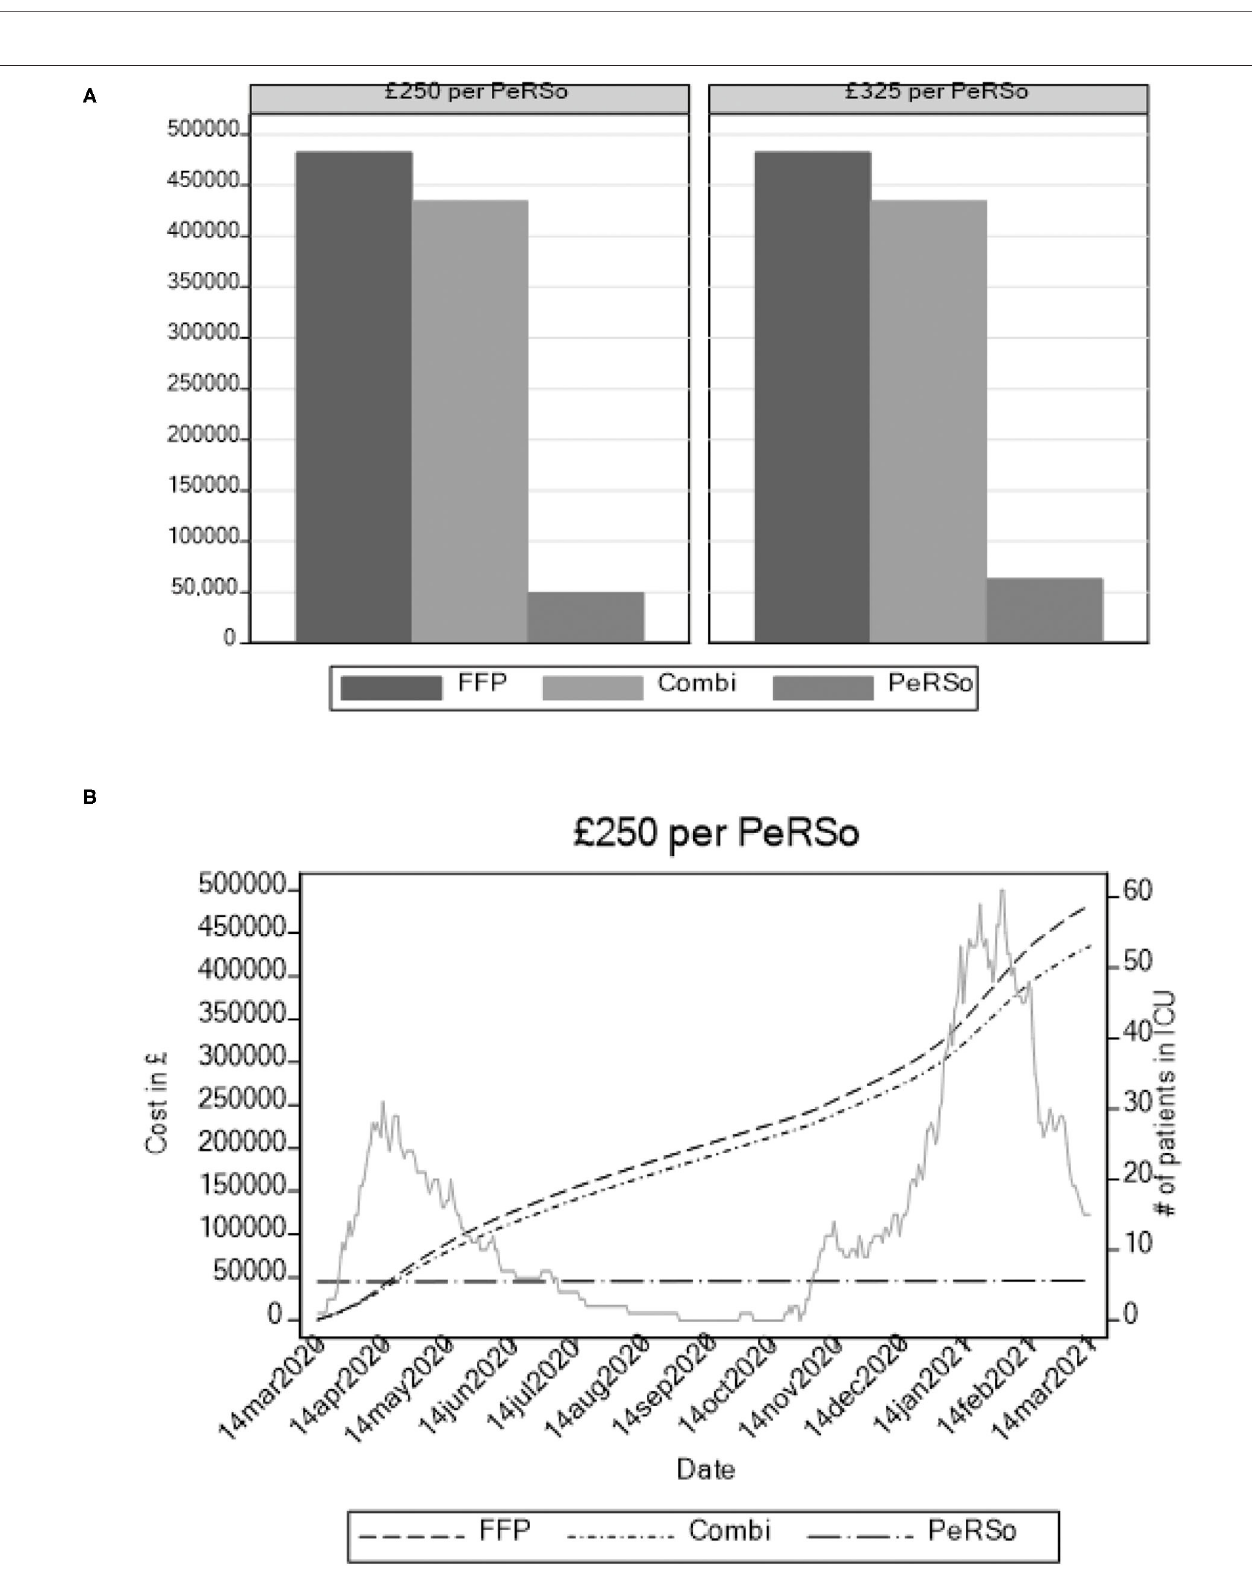
FIGURE 3 | Modeling of cumulative annual cost of three PPE strategies based on admission rates at University Hospital Southampton intensive care unit admissions. (A) Total cost accumulated over 12 months. (B) Cumulative costs over time, with ITU admission rate plotted in background to demonstrate waves.